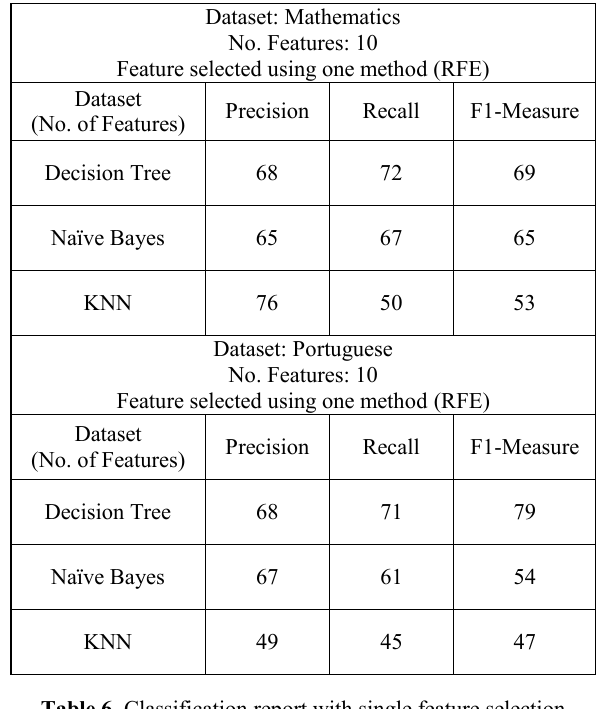
Table 6. Classification report with single feature selection (RFE)